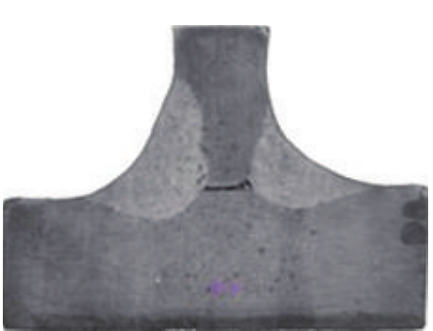
Figure 16: Incomplete penetrated corner joints of impeller blade.